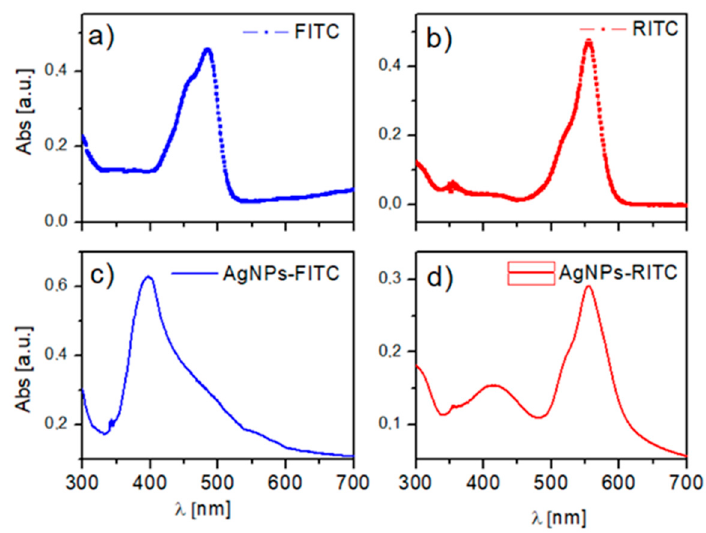
Figure 2. UV–Vis spectra of ( a ) FITC; ( b ) RITC; ( c ) AgNPs–FITC; ( d ) AgNPs–RITC samples in Figure 2. UV–Visspectraof( a )FITC;( b )RITC;( c )AgNPs–FITC;( d water solution.